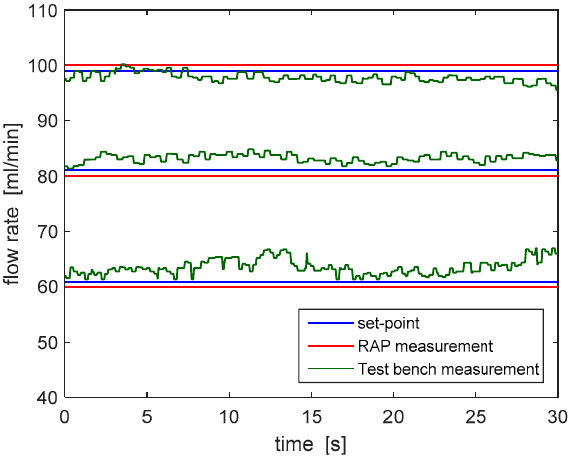
Figure 10. Blood flow rate estimated in the RAP and measured by the test bench at different set values (60, 80 and 100 mL/min).